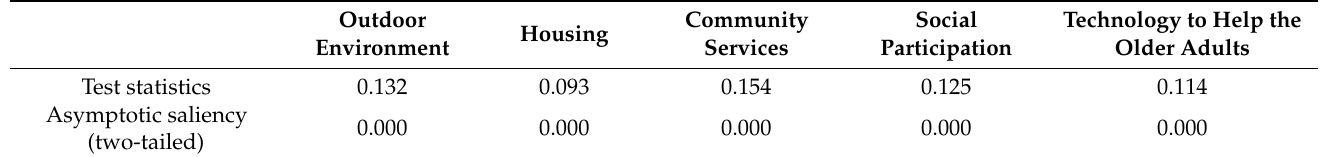
Table 7. Kolmogorov–Smirnov test results.